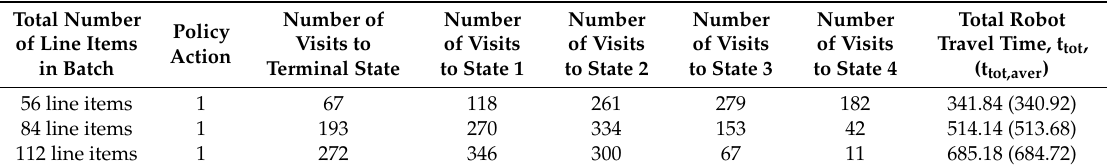
Table 5. Simulation results for the scheduling of one batch of 28 orders, with mean order size (i) 2 line item per order; (ii) 3 line items per order; and (iii) 4 line items per order. The number in parentheses shows the calculated average total robot travel time, t tot,aver , from 1000 simulation replications.